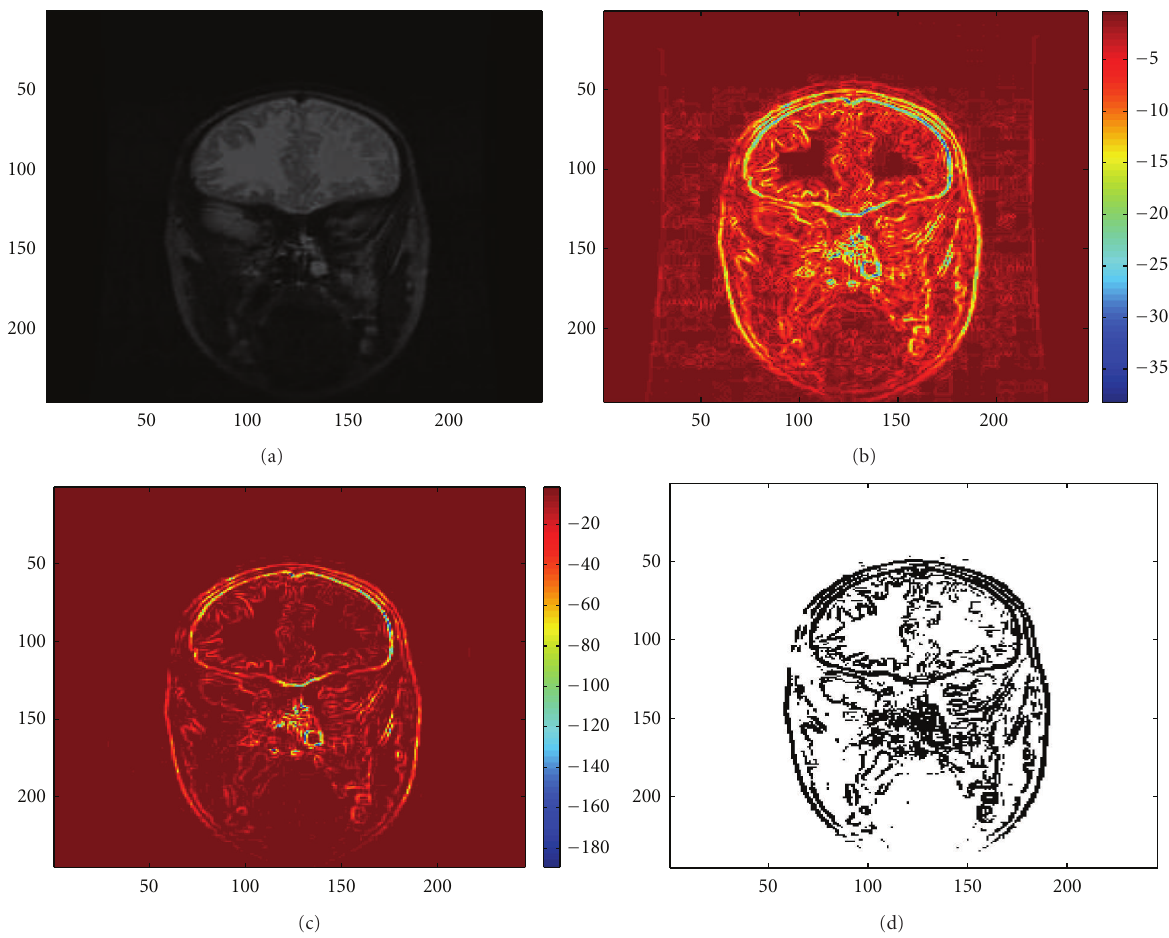
Figure 3: (a) Original image; (b) L 2 norm of the (standard) gradient of (a); (c) Topological gradient of (a); (d) Identified edges by thresholding the topological